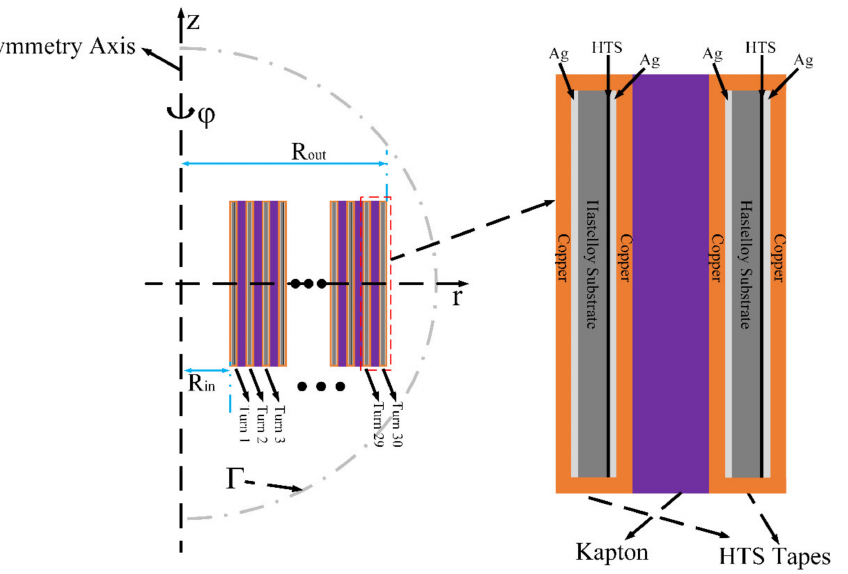
Figure 1. A two-dimensional axisymmetric model of a cross section of the HTS REBCO